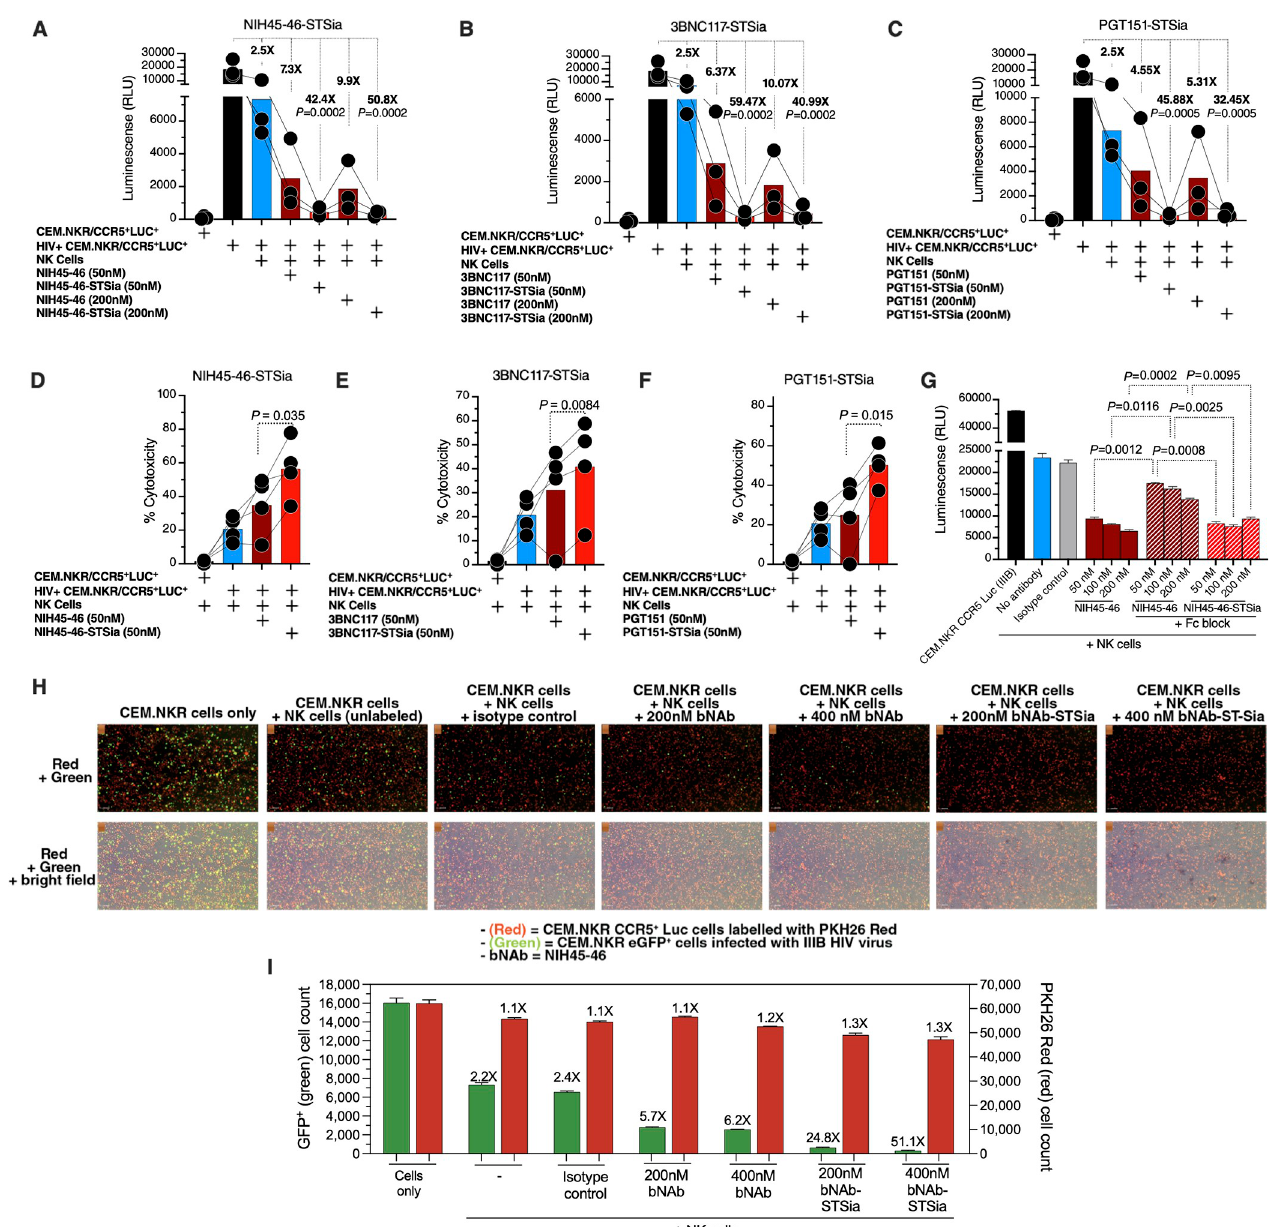
Fig 7. bNAbs-STSia conjugates promote higher NK cytotoxicity against HIV+ cells compared to bNAbs alone. (A-C) Killing assay using HIV-infected CEM-NKR CCR5 + Luc + cells as targets and HIV-negative primary NK cells as effectors (n = 3 donors; assays from each donor were performed in 2–4 replicates, and the average of these replicates was used for analysis) at E:T ratio of 10:1. Luminescence was measured as a marker of intact (unkilled) HIV+ cells. (A) NIH45-46 and its conjugate. (B) 3BNC117 and its conjugate. (C) PGT151 and its conjugate. P -values were calculated using paired ANOVA with post-hoc Holm-Sidak method (comparing each condition against the HIV+ cells alone condition). (D-F) Killing assay using HIV-infected CEM-NKR CCR5 + Luc + cells as targets and HIV-negative primary NK cells as effectors (n = 4 donors; assays from each donor were performed in 2–4 replicates, and the average of these replicates was used for analysis). Cytotoxicity was assessed by the LDH release assay at an E:T ratio of 10:1. (D) NIH45-46 and its conjugate. (E) 3BNC117 and its conjugate. (F) PGT151 and its conjugate. p - values were calculated using paired t-tests. (G) NK cells were treated with human Fc receptor blocking solution prior to co-incubation with HIV-infected CEM.NKR CCR5 + Luc + cells. Luminescence was measured following 16 h incubation at a 10:1 E:T ratio. Unpaired ANOVA with post-hoc Dunnett T3 method (to correct for multiple comparisons) was used for statistical analysis between the indicated groups. (H) Effector NK cells were isolated from PBMC of an ART-suppressed HIV+ donor (ART09) and co-cultured with a mixture of HIV-uninfected PKH26-labeled CEM.NKR CCR5 + Luc + (red cells) and HIV-infected CEM.NKR eGFP + cells (green cells). Cell mixture was treated with NIH45-46, NIH45-46STSia, or isotype control. After 24 of co-culture, the Celigo image cytometer was used to directly visualize and count the number of PKH26-labeled (red) and GFP + (green) target cells. The panel shows representative images from two independent experiments. This experiment was performed in quadruplicate at E:T 10:1. (I) Plot of the raw